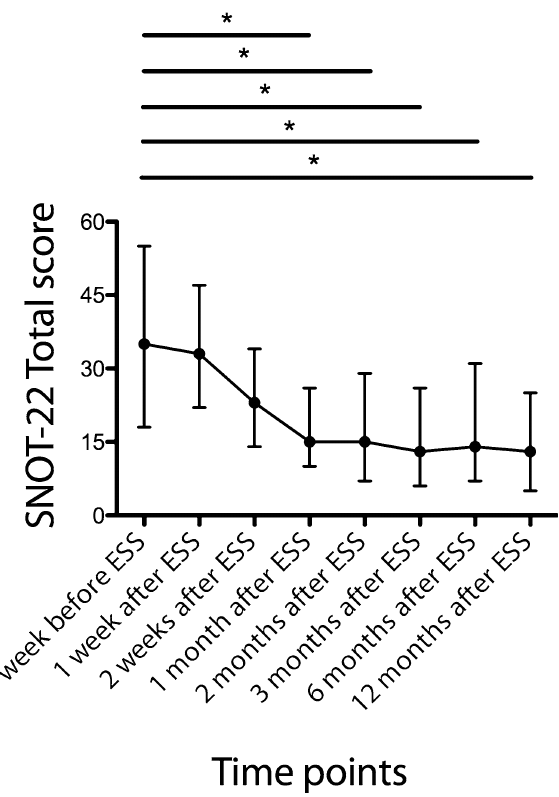
Figure 1. Changes in SNOT-22 total symptom scores over time. Data are presented as medians and interquartile ranges. Results of post-hoc analysis with Dunn’s multiple comparison test: * p < 0.001. ESS endoscopic sinus surgery, SNOT-22 22-item Sino-Nasal Outcome Test.